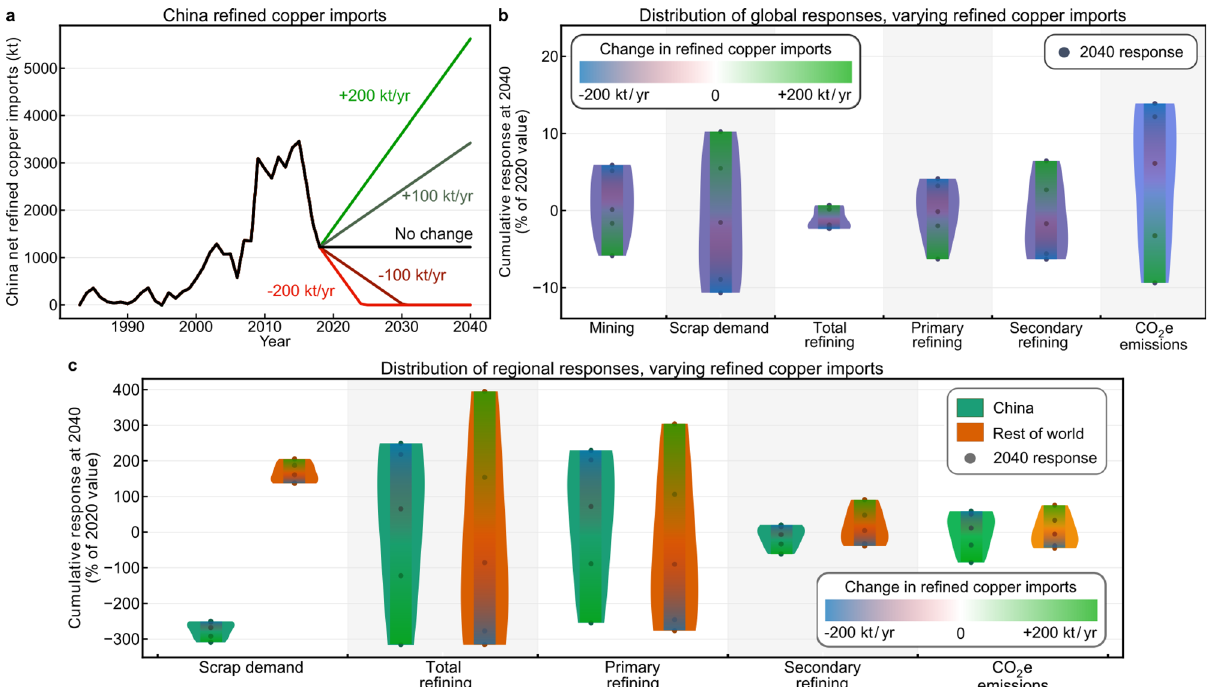
Fig. 4 Results of changing China ’ s re fi ned copper imports alongside the No.2 scrap ban. a Historical Chinese net re fi ned copper imports and scenario de fi nition, where re fi ned copper imports are increased or decreased at rates of 100 or 200 kt/year, with minimum value zero. b Violin plot showing the distributions of global responses for varying re fi ned copper imports, where CO 2 e emissions are highlighted as an aggregate response. Points show the values for each of the fi ve scenarios and color bar indicates directionality. Primary, secondary, and total re fi ning use the total re fi ning value as divisor. c Violin plot showing the distributions of regional responses for each supply chain actor, with CO 2 e emissions highlighted as a system-level response. Points show the values for each of the fi ve scenarios and color bar indicates directionality. China is shown in green, RoW in orange. CO 2 e emissions use the global value as divisor for ease of comparison; the extrema using local divisors are China: − 270% and 170%, RoW: − 120% and 210%. Primary, secondary, and total re fi ning use the regional total re fi ning value as divisor. Underlying data used to create this fi gure may be found in a data repository at https://doi.org/ 10.6084/m9. fi